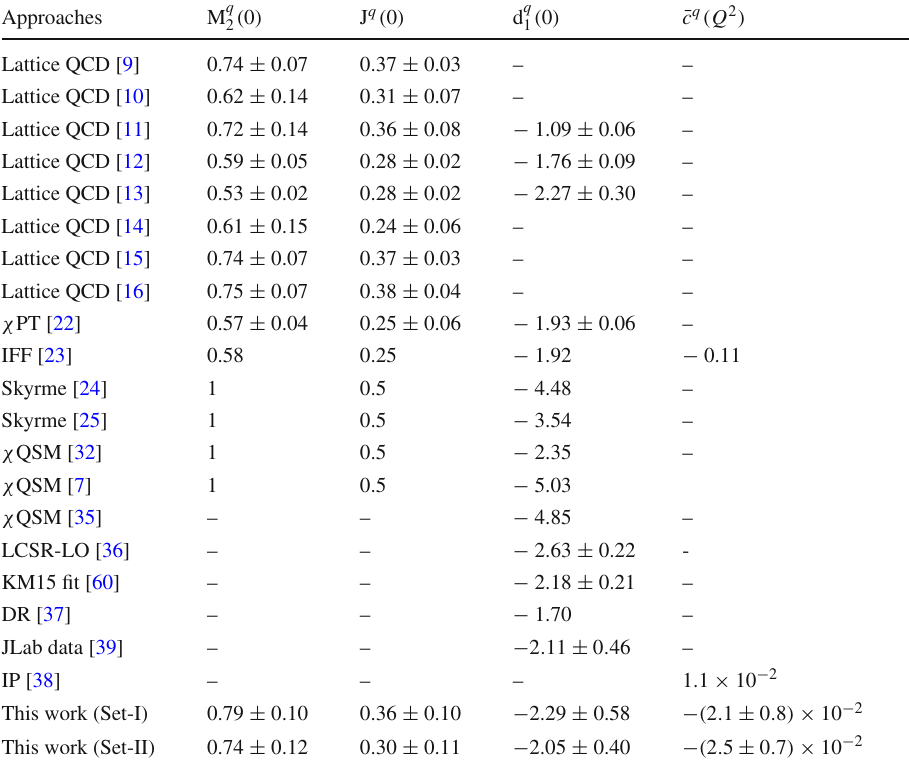
Table 3 The EMTFFs of nucleon at re-normalization scale μ 2 = 1 . 0 GeV 2 compared with other predictions and JLab data. The Skyrme and χ QSM models predictions were obtained considering both the quark and gluon parts of the EMT current and they are re-normalization scale